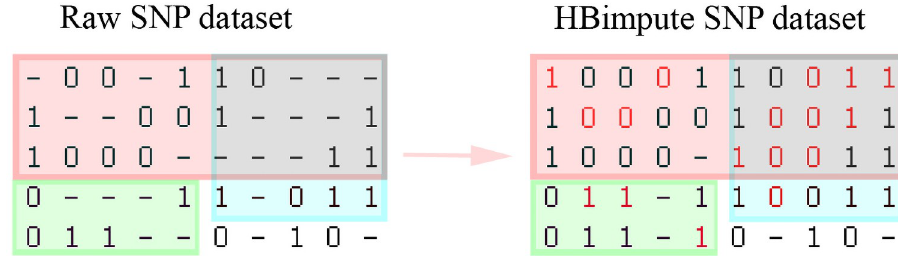
Fig 6. Toy example for the HBimpute step. Each column represents a SNP and each row represents a haplotype (for inbred lines: individual). Haplotype blocks are indicated by colored blocks. The blue and red block are overlapping.